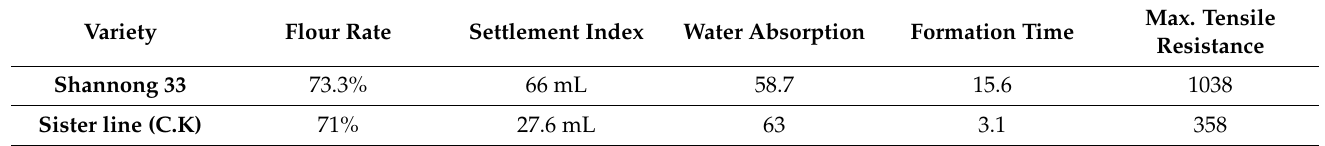
Table 1. Analysis of variance for quality parameters of the used material in this study.